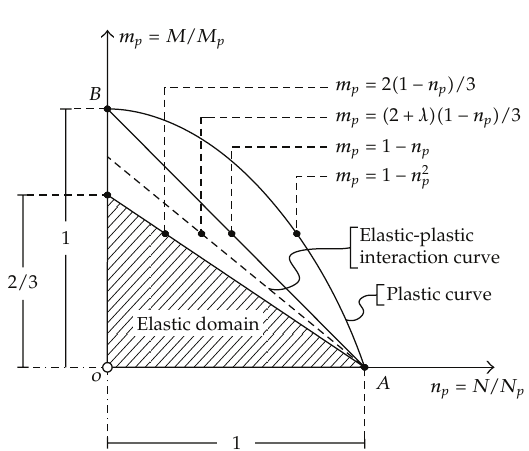
Figure 6: Elastic, elastic-plastic, and plastic loci in the n p − m p